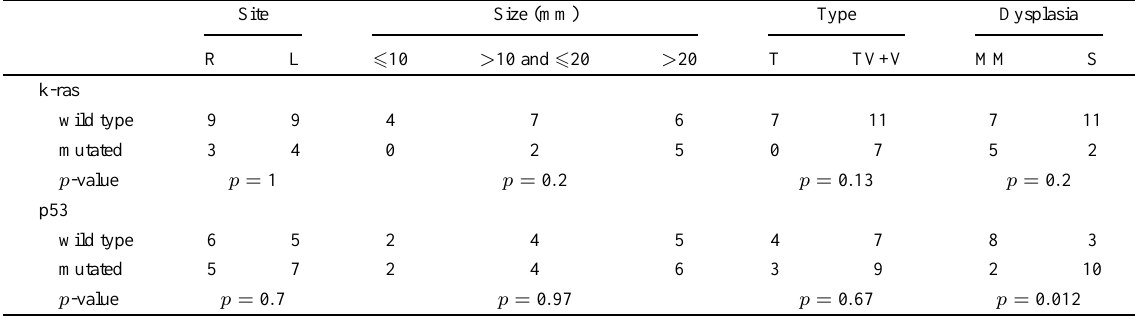
Associations of k-ras and p53 mutational status with site, size, type and dysplasia among human colorectal adenomas containing early cancer